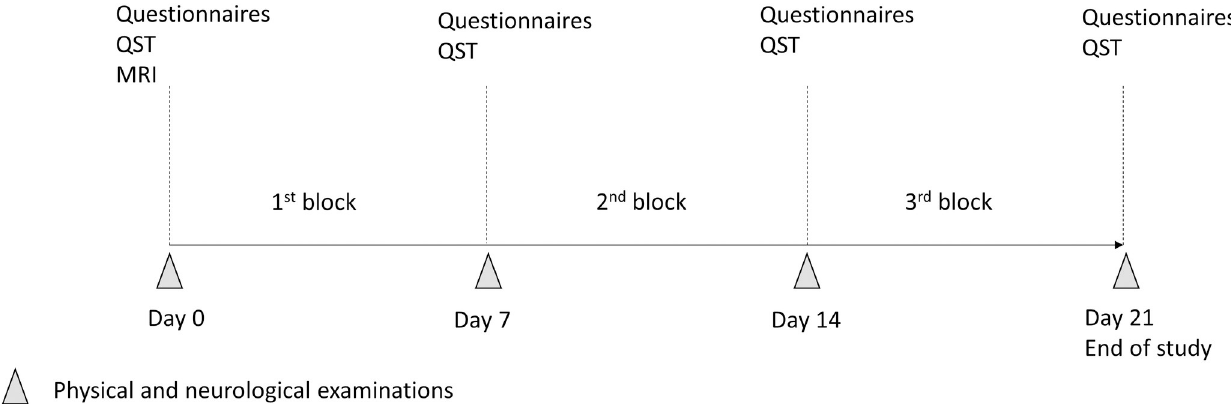
Fig 1. Timeline of the study. Dogs were randomized to receive either treatment 1 or 2. Pain assessment and Quantitative Sensory Testing (QST) were evaluated after each block of treatment (7 days). Abbreviations: QST, quantitative sensory testing (including mechanical and electrical nociceptive thresholds and assessment of the descending noxious inhibitory controls); MRI, magnetic resonance imaging.